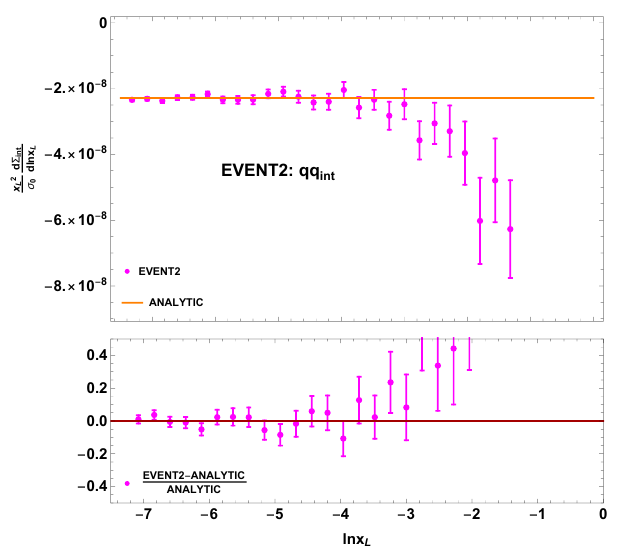
Figure 11. The identical quark interference term compared with Event2 for an equilateral triangle